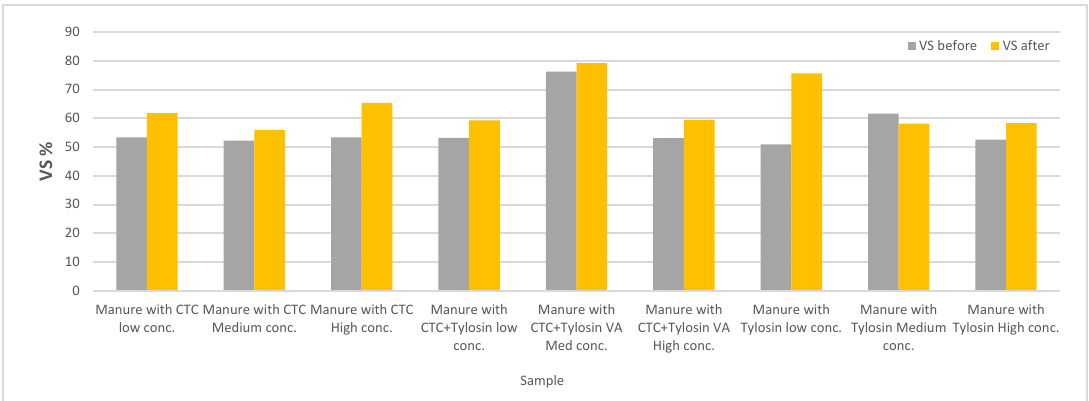
Figure 5. Digestate volatile solid (VS) concentrations before and after VA additions.